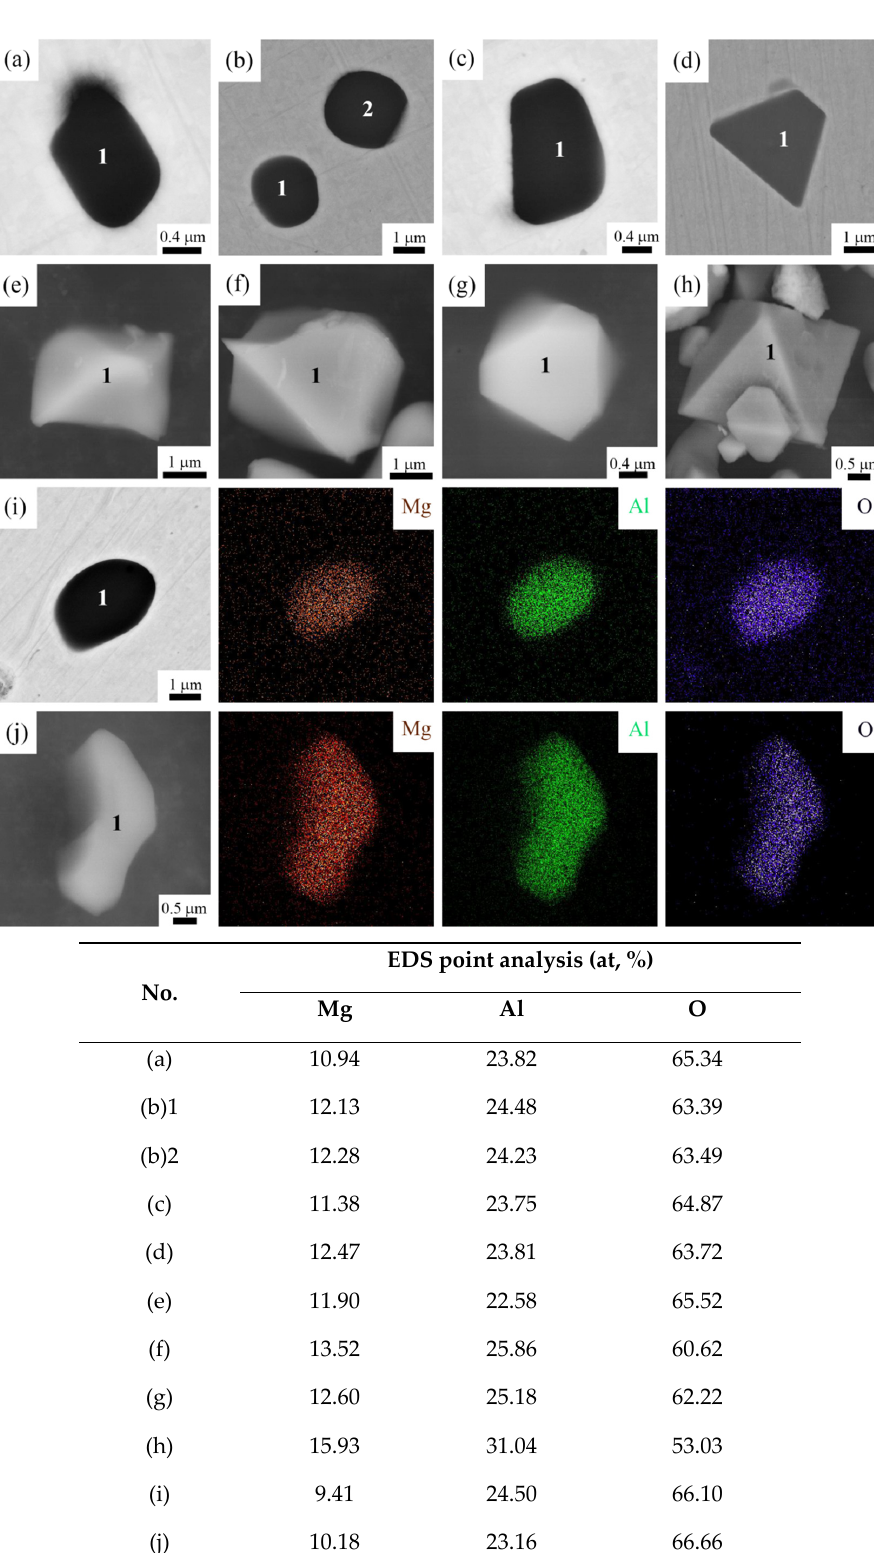
Figure 3. 2D and 3D morphologies of single-particle MgAl 2 O 4 inclusion. ( a , c ) Long-strip MgAl 2 O 4 ; ( b ) Ellipsoidal MgAl 2 O 4 ; ( d ) Trapezoidal MgAl 2 O 4 ; ( e – h ) Regular crystalline octahedron MgAl 2 O 4 ; ( i , j ) are dots and long-strip MgAl 2 O 4 with elements